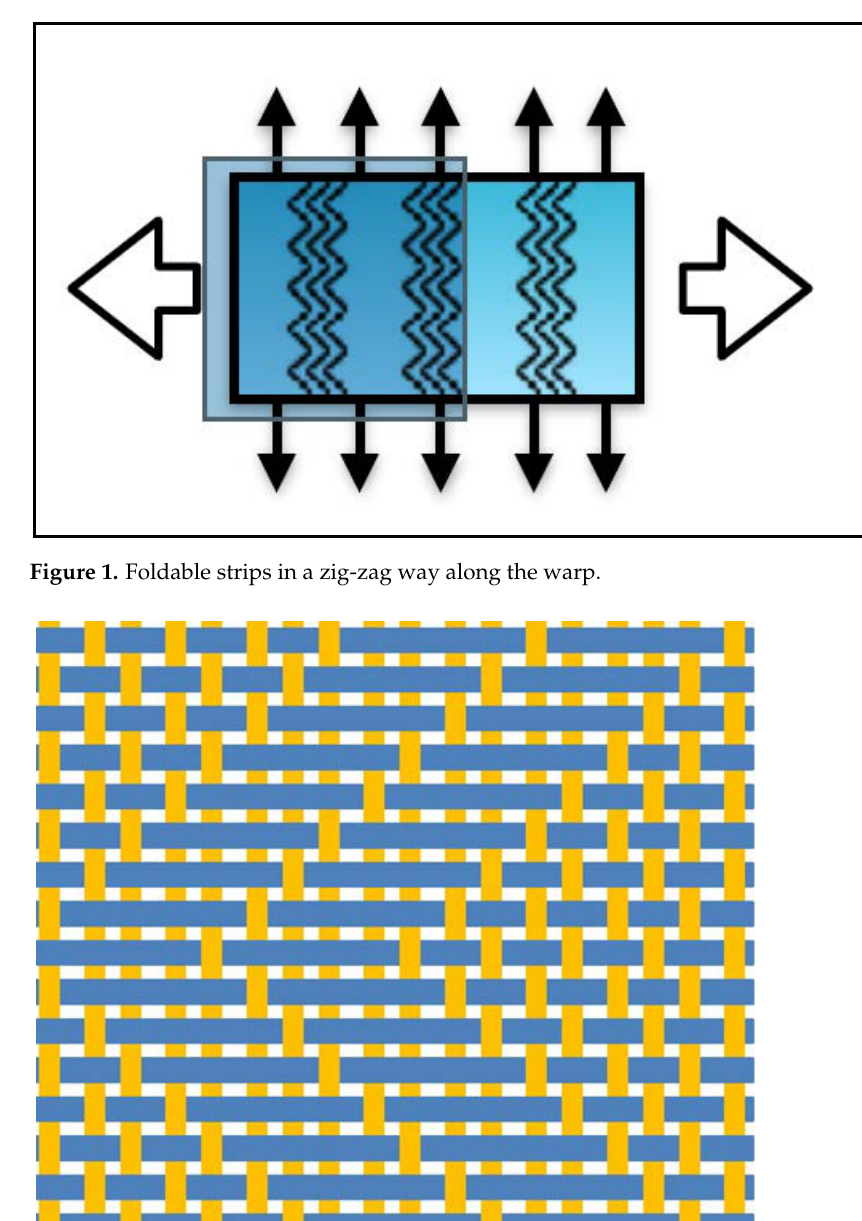
Figure 2. Unit cell of auxetic weave design.